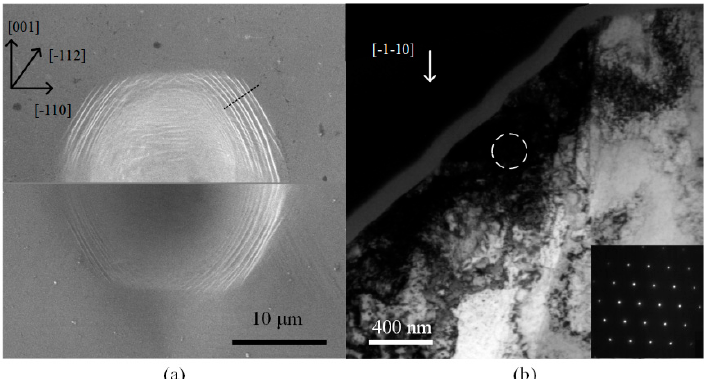
Figure 17. Morphology of (110) copper indentation at 150 K. ( a ) SEM result. ( b ) TEM result at the ( a ) cutting direction [64].